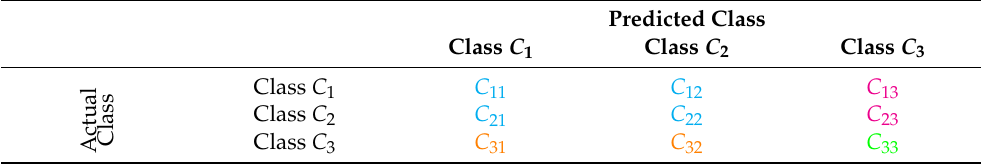
Table 6. Multi-class confusion matrix. The colored cells correspond to the true positives (green), true negatives (cyan), false negatives (orange), and false positives (magenta) associated with the C 3